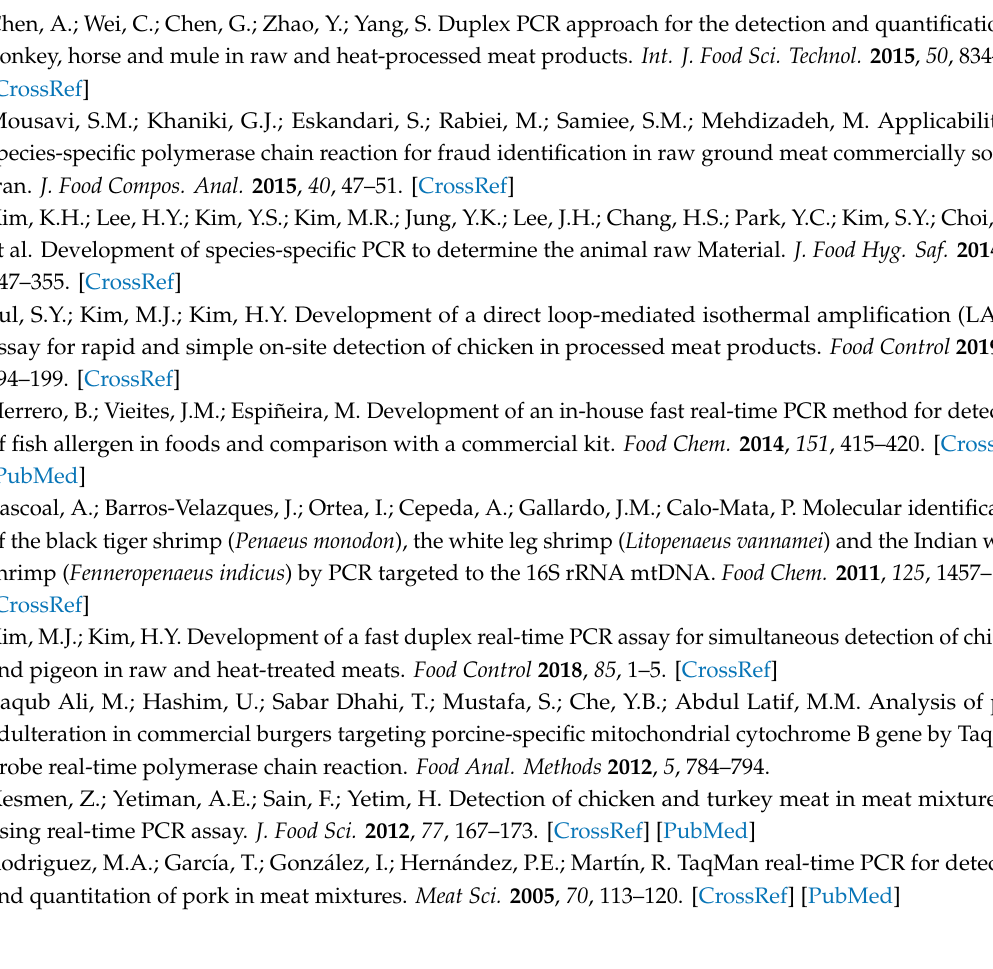
Figure S1: The identity result of sequences of the PCR products for donkey-specific primer